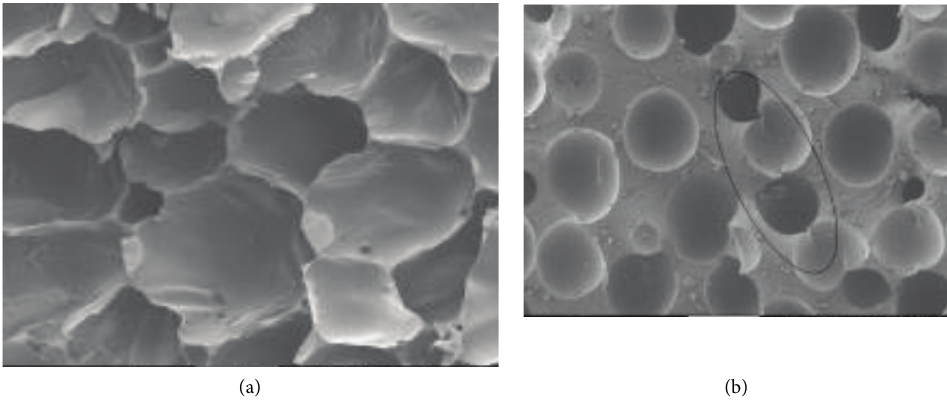
Figure 7: SEM images of the polymer at densities of (a) 0.15g/cm 3 and (b) 0.57g/cm 3 .